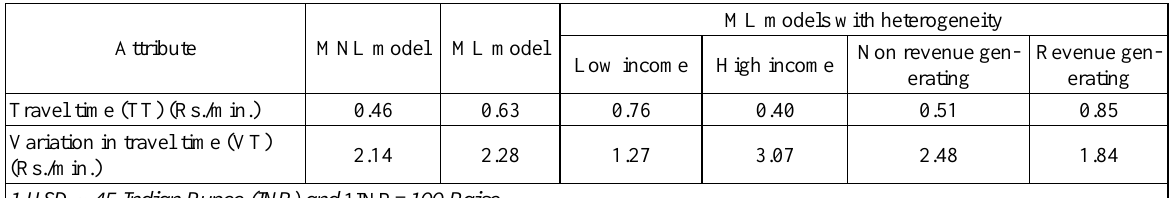
Table 7. Value of travel time and its variation for taxi trip